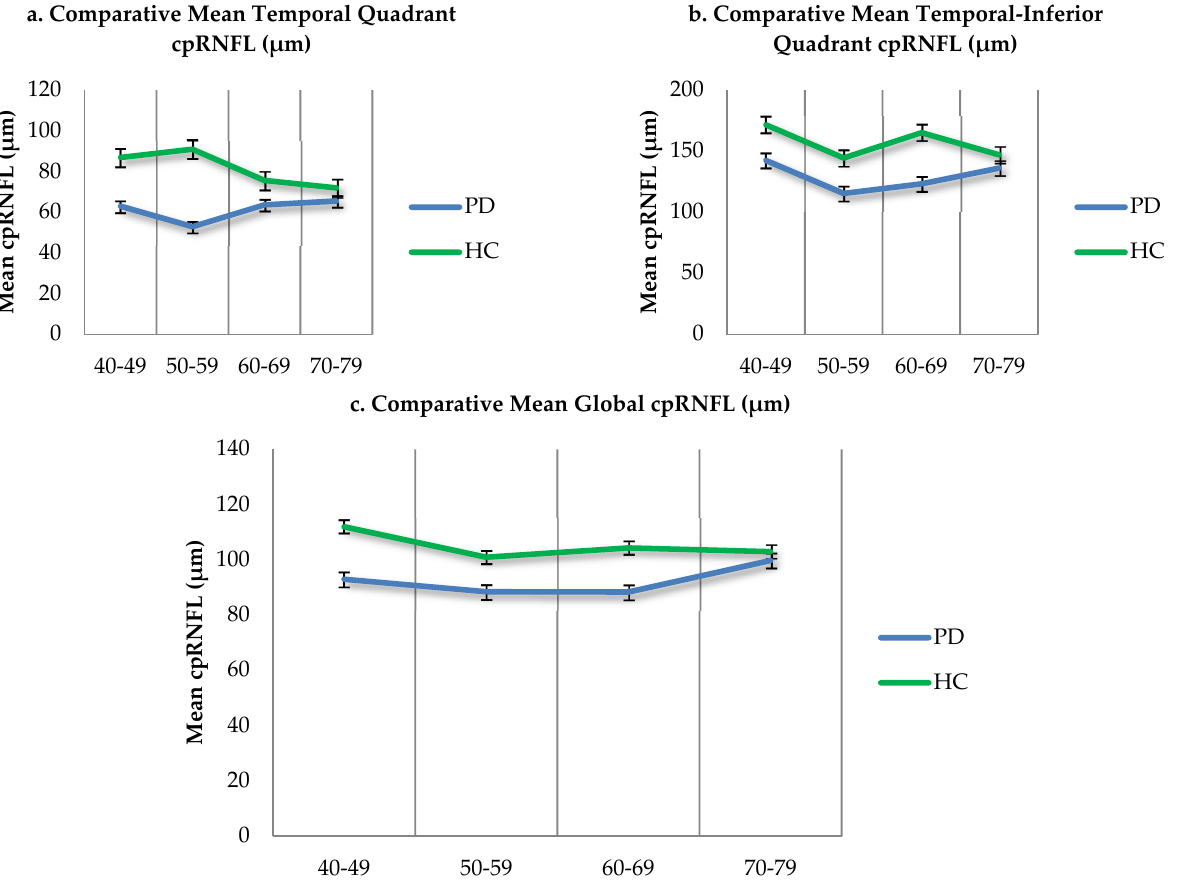
Figure 3. ( a – c ). Comparative mean cpRNFL values in PD patients and age matched controls. Standard error—black bars.